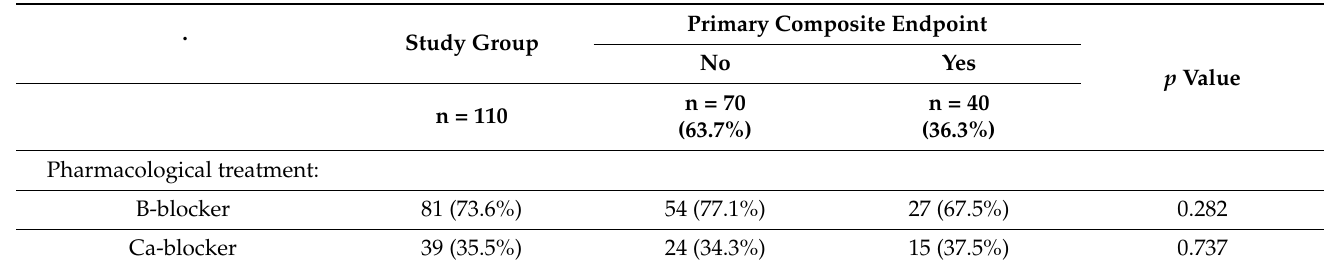
Table 2. Pharmacological treatment at discharge in the study group. Comparison between subgroups divided based on primary composite endpoint